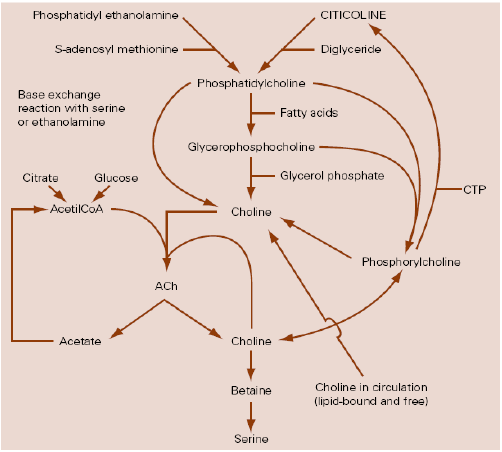
Figure 1. Relationship between citicoline and choline metabolism, cerebral phospholipids and acetylcholine. ACh: Acetylcholine; CTP: Cytidin triphosphate (modified from Secades, J.J.; Lozano, R . Traumatismos craneoencefálicos: revisión fisiopatológica y terapéutica. Aportaciones de la cit- icolina. Excerpta Medica. Amsterdam, The Netherlands, 1991). acetylcholine. ACh: Acetylcholine; CTP: Cytidin triphosphate (Adapted with permission